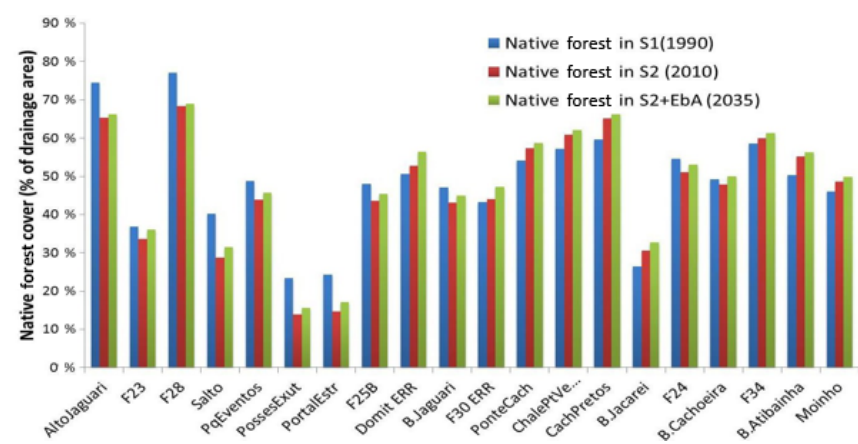
Figure 9. Native forest cover in S1 (1990), S2 (2010) and S2 + EbA